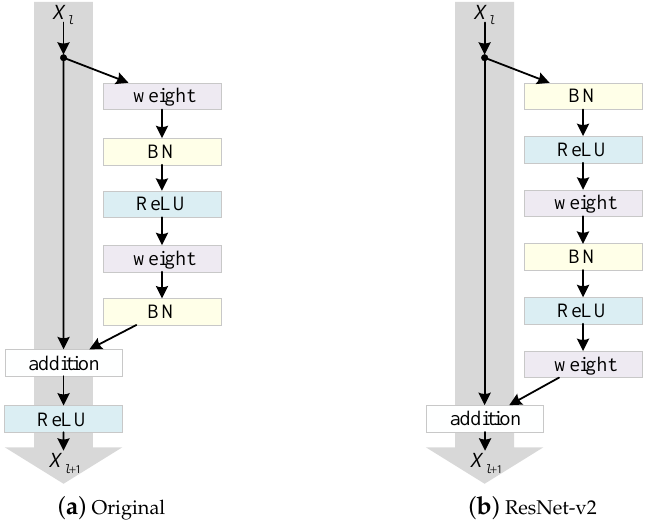
Figure 3. ( a ) Original Residual Unit in He et al. [39]; ( b ) ResNet-v2 Unit [40]. Gray arrows indicate easiest paths for information